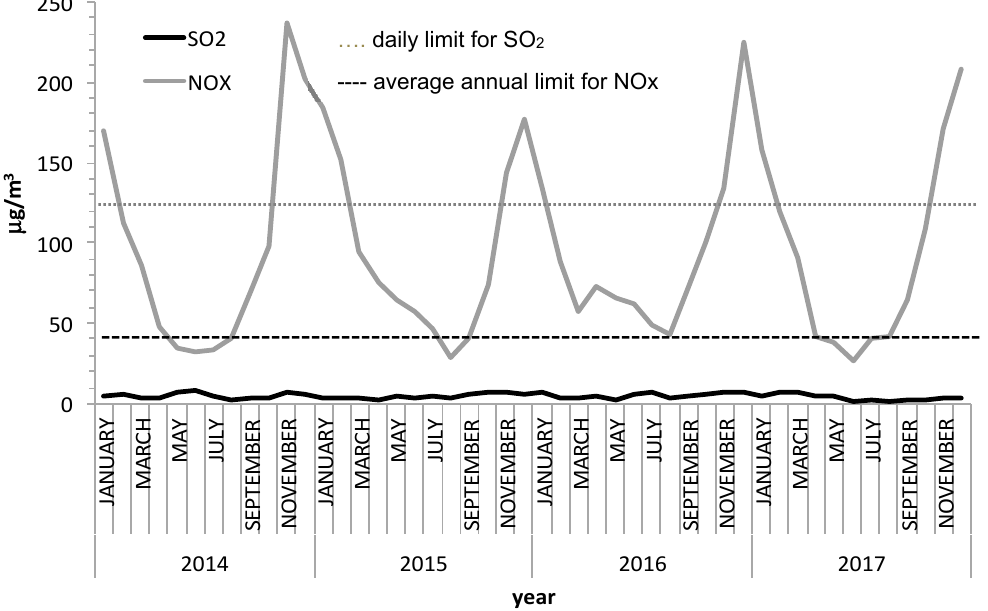
Figure 3. NO x and SO 2 concentrations trend registered for Milan monitoring sites (data from ARPA Lombardia) during the period of interest for the exposure field tests (2014–2017); daily limit and average annual limit respectively for SO 2 and NO x (according to D. Lgs. 155/2010) have been reported.